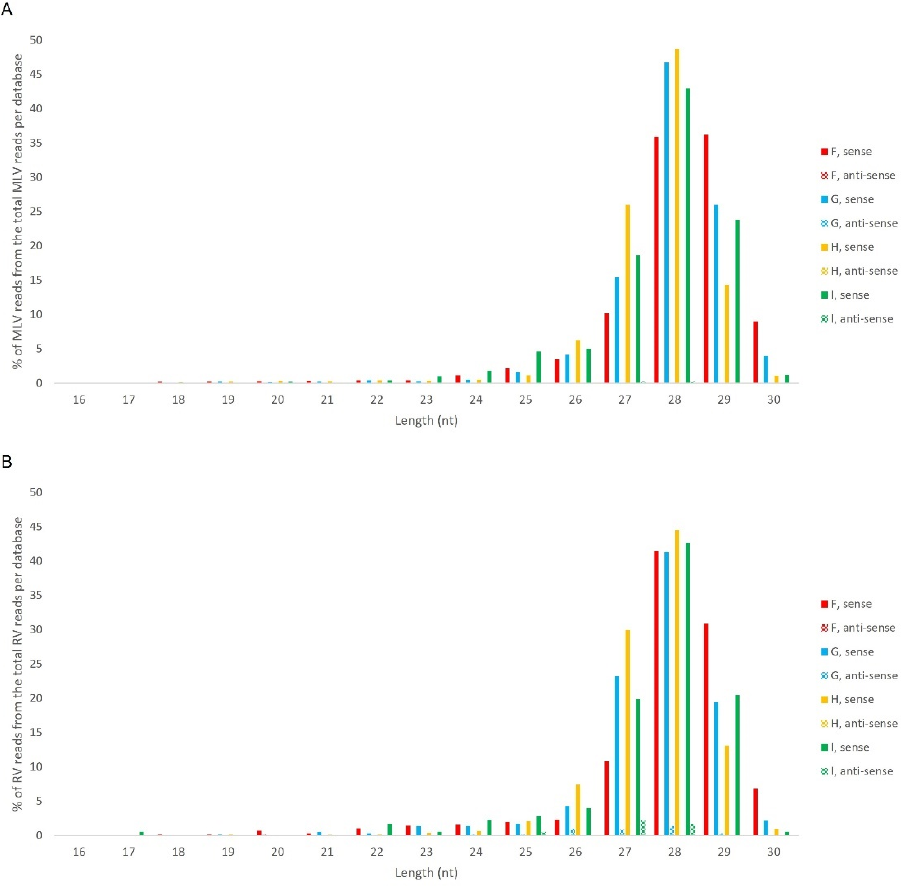
Figure 10. Length distribution of Siwi-bound sRNAs, derived from BmN4 cells, mapping to B. mori Macula-like Latent Virus (MLV) ( A ) and S. frugiperda Rhabdovirus (RV) ( B ). The Y -axis represents the percentage of viral reads for each length, in the total of the 16–30 nt viral reads. The X -axis represents the length of the reads in nucleotides. Solid bars: sense reads. Dotted bars: anti-sense reads. F–I: represented databases, listed in Table S2.